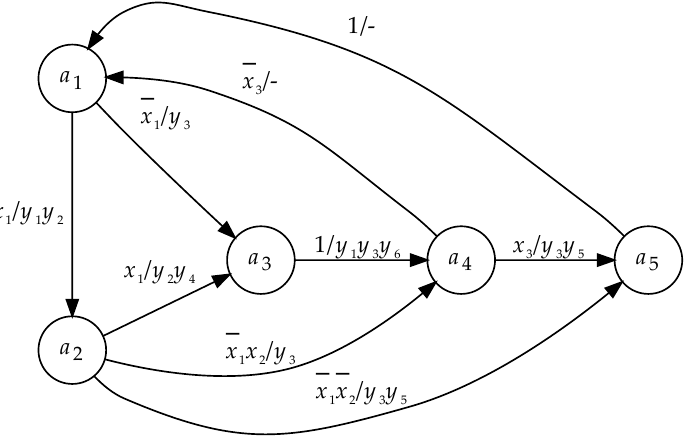
Figure 7. STG of Mealy FSM S 1